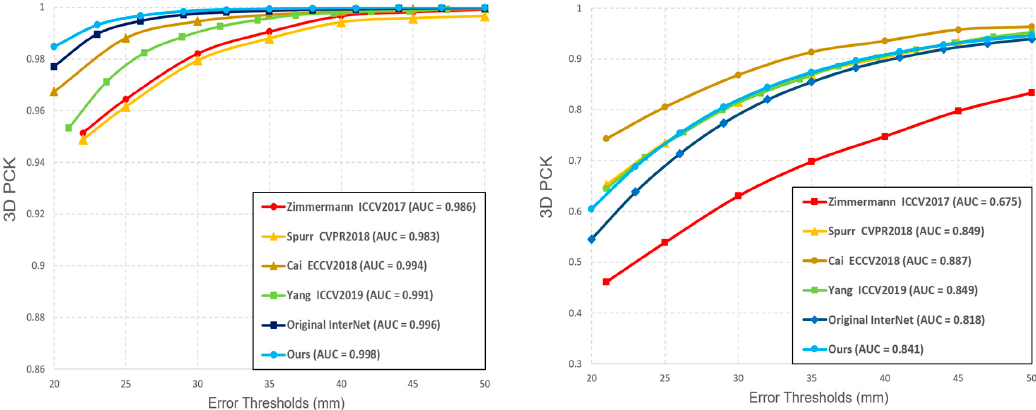
Figure 5. Quantitative evaluation for different methods on STB dataset and RHD dataset. ( Left ): 3D PCK on STB dataset. ( Right ): 3D PCK on RHD dataset.